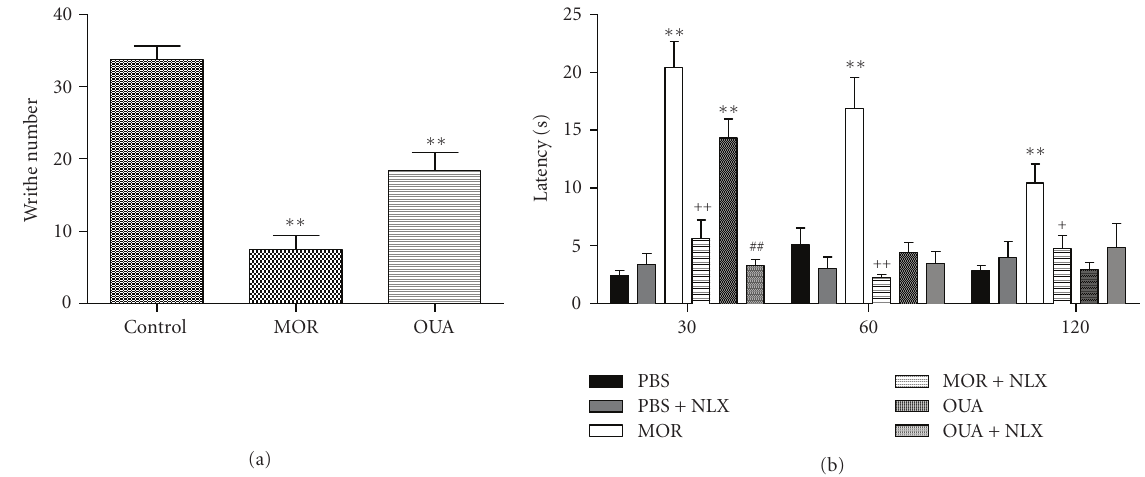
Figure 5: E ff ect of the pretreatment with Ouabain (OUA, 0.56mg/kg) administered intraperitoneally on acetic acid-induced writhing and hot plate test in mice. Each bar represents the mean of six or ten animals. Morphine (MOR, 10mg/kg) administered intraperitoneally was used for analgesia. Naloxone (NLX, 5mg/kg), an opioid antagonist, was used to test the involvement of opioid receptors. Asterisks denote the significance level compared with control values; # compared with the Ouabain group and + compared with the morphine group. Data were expressed as mean ± S.E.M. and analyzed by software Graphpad Prism using (ANOVA) followed Dunnett’s test . ∗ P < . 05, ∗∗ P < . 01, and ∗∗∗ P < .